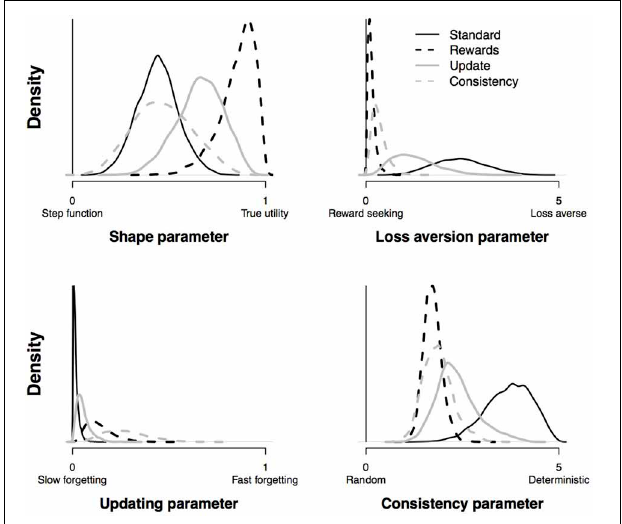
FIGURE 10 | Posterior distributions for the group-level parameters of the PVL-Delta model in the four experimental